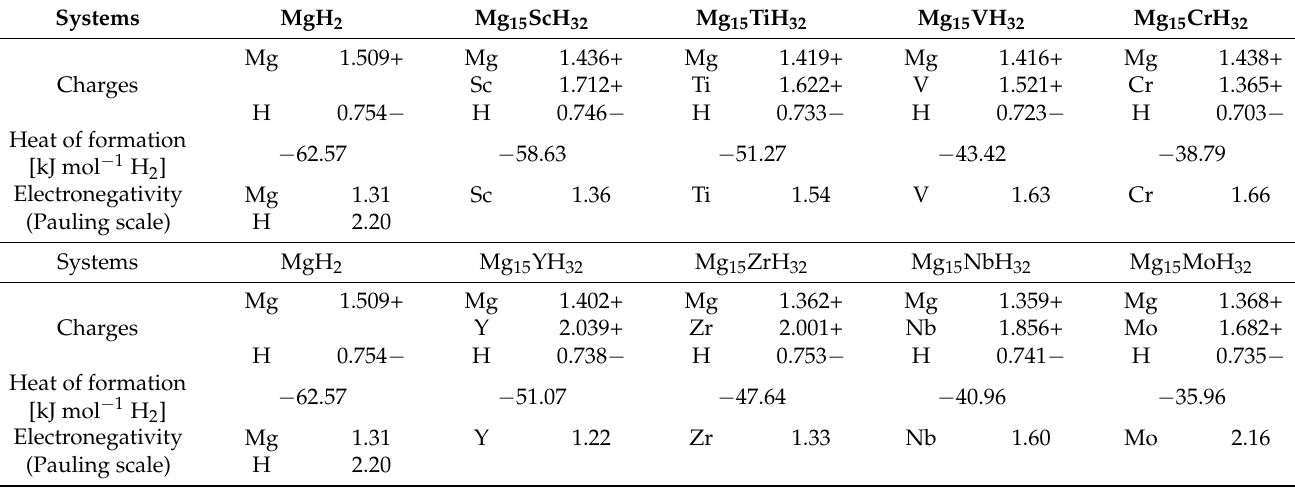
Figure 9. Interstitial occupation of Mn in the MgH 2 (001) surface. ( a ) The final structure and ( b ) the total and partial densities of states. The small blue, the medium green, and the large red balls denote H, Mg, and Mn atoms, respectively. ( a , b ) Reproduced with permission [178]. Copyright 2011, Elsevier. ( c ) (Left) original unit cell of MgH 2 , (right) 2 × 2 × 2 primitive supercell used in MgH 2 –TM (Mg 15 TMH 32 ) calculations. ( d ) Orbital momentum decomposition ( l = 0, 1, 2 correspond to columns 1, 2, and 3, respectively) of spin-polarized MgH 2 –Co atomic densities of states: Co (top), Co nearest neighbor Mg (second row), and the two non-equivalent Co nearest neighbor H atoms (the two bottom rows). ( c , d ) Reproduced with permission [179]. Copyright 2009, Elsevier. Table 4. The charge density of elements, electronegativity of TM, and heat of formation for single substituted Mg-based hydrides Mg 15 TMH 32